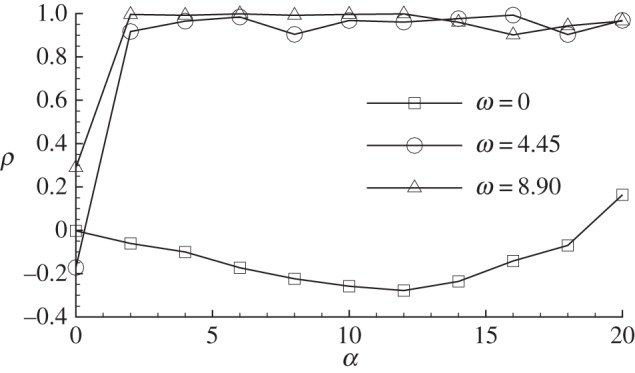
Correlation between sensitivities of lift and drag at Re=1000.